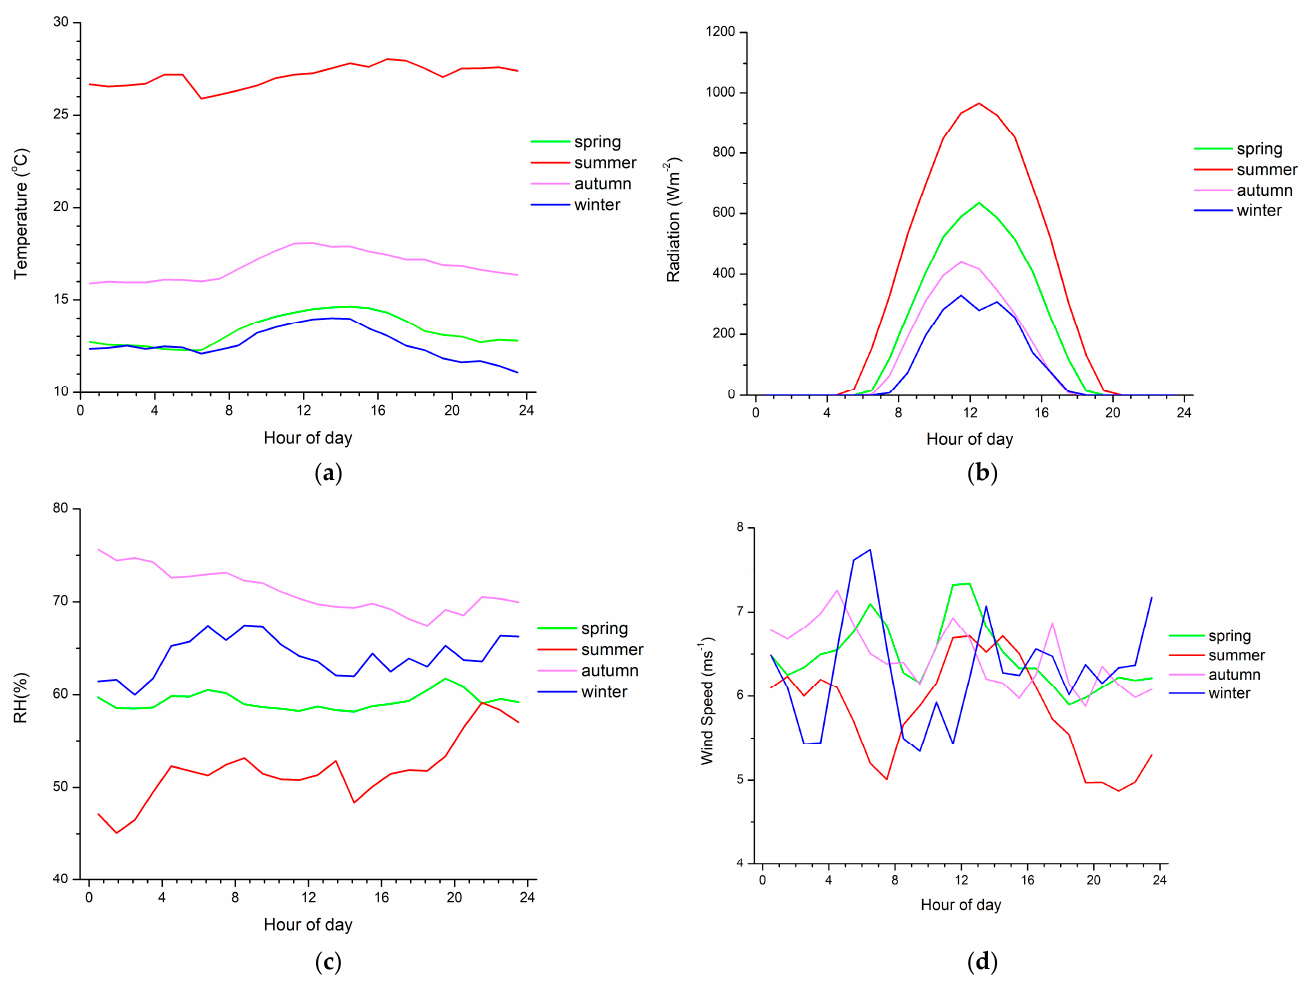
Figure 3. Diurnal variability of ( a ) temperature, ( b ) solar radiation, ( c ) relative humidity and ( d ) wind speed near surface averaged over the days of the observations during each season from March 2014 to April 2015. Table 3. Varimax-rotated factor matrix resulting from the factor analysis showing the correlations between atmospheric chemical components and